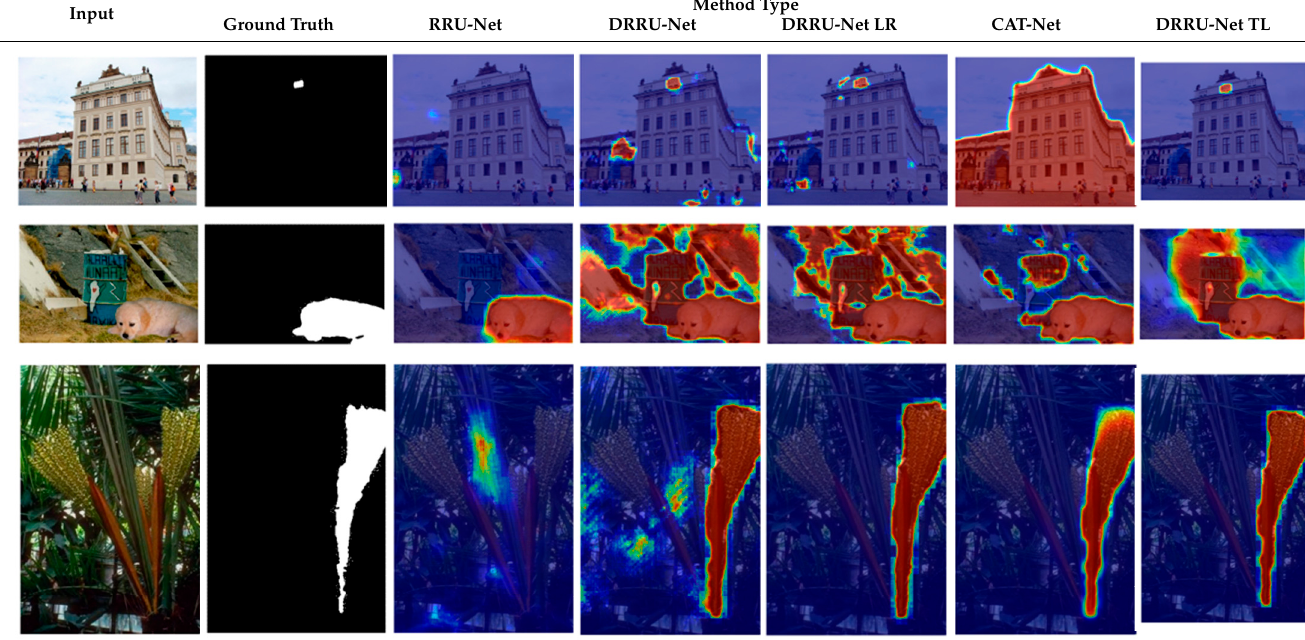
Table 5. Comparison of the prediction performance of forgery regions among all networks.